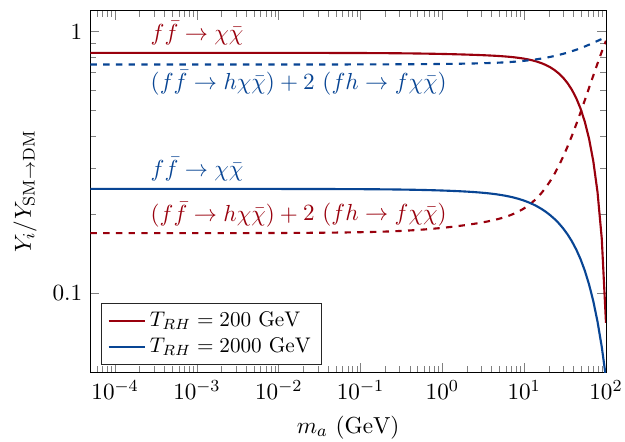
¯ Figure 6 . Relative contributions of infrared-dominated interaction f f → χ ¯ χ (solid) and ultraviolet- dominated 2 → 3 interactions ( f ¯ f → hχ ¯ χ ) + 2( fh → fχ ¯ χ ) (dashed) to the final χ -abundance as a function of the ALP mass in the freeze-in from SM regime for reheating temperatures T = RH 200 GeV (red) and T = 2000 GeV (blue). We fixed the ratio m = 10 . RH χ /m a hatched region production from ALP scattering (freeze-in from ALPs). These freeze-in regimes span a vast region of parameter space in the ( m ) -plane. We cut the plot , g a aff at the upper theoretical bound C 4 π which results in g = C 1 GeV − 1 since /f a . f . aff f f (cid:29) v with v the electroweak scale, cf. appendix A. Below the lower boundary the χ a